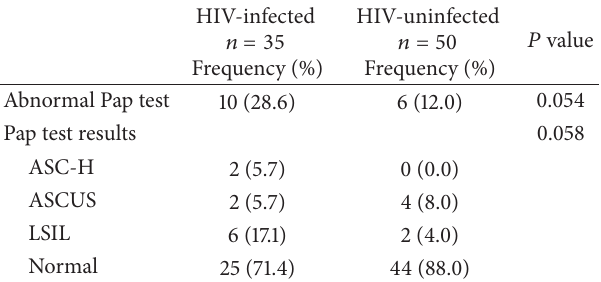
Table 3: Pap test results by HIV